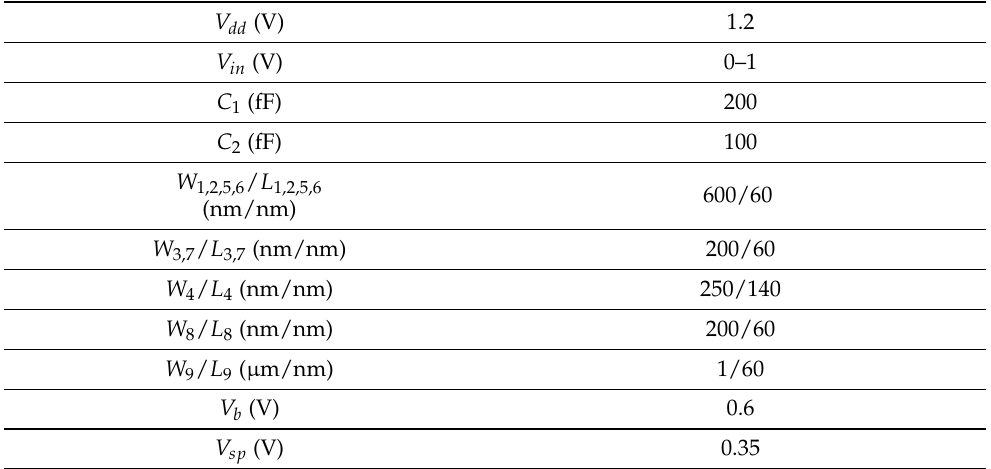
Table 1. VTC’s design parameters.